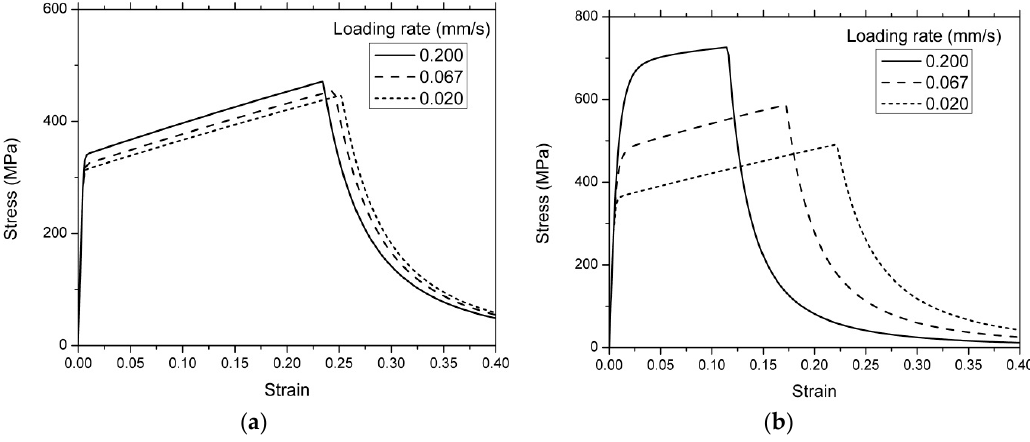
Figure 2. Stress ‐ strain responses for different loading rates ( a ) (cid:2035) (cid:3404) 0.1 ; ( b ) (cid:2035) (cid:3404) 1.0 . Figure 2. Stress-strain responses for different loading rates ( a ) (cid:101) = 0.1; ( b ) (cid:101) =